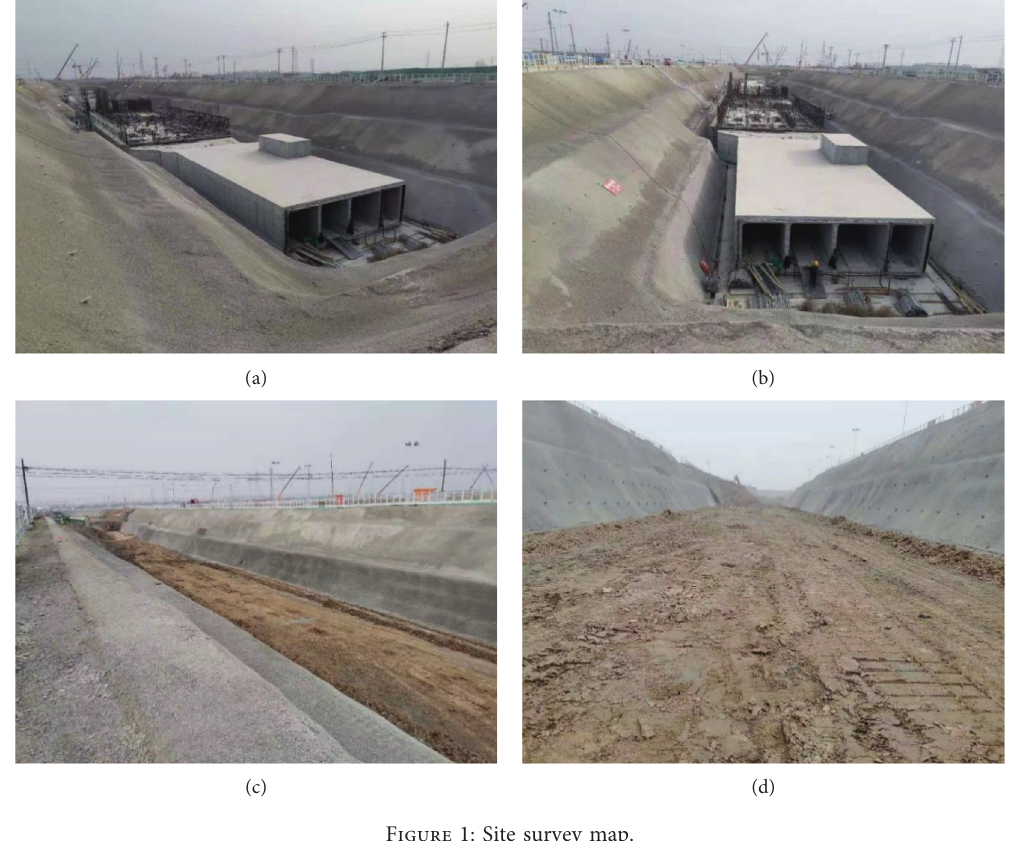
Figure 1: Site survey